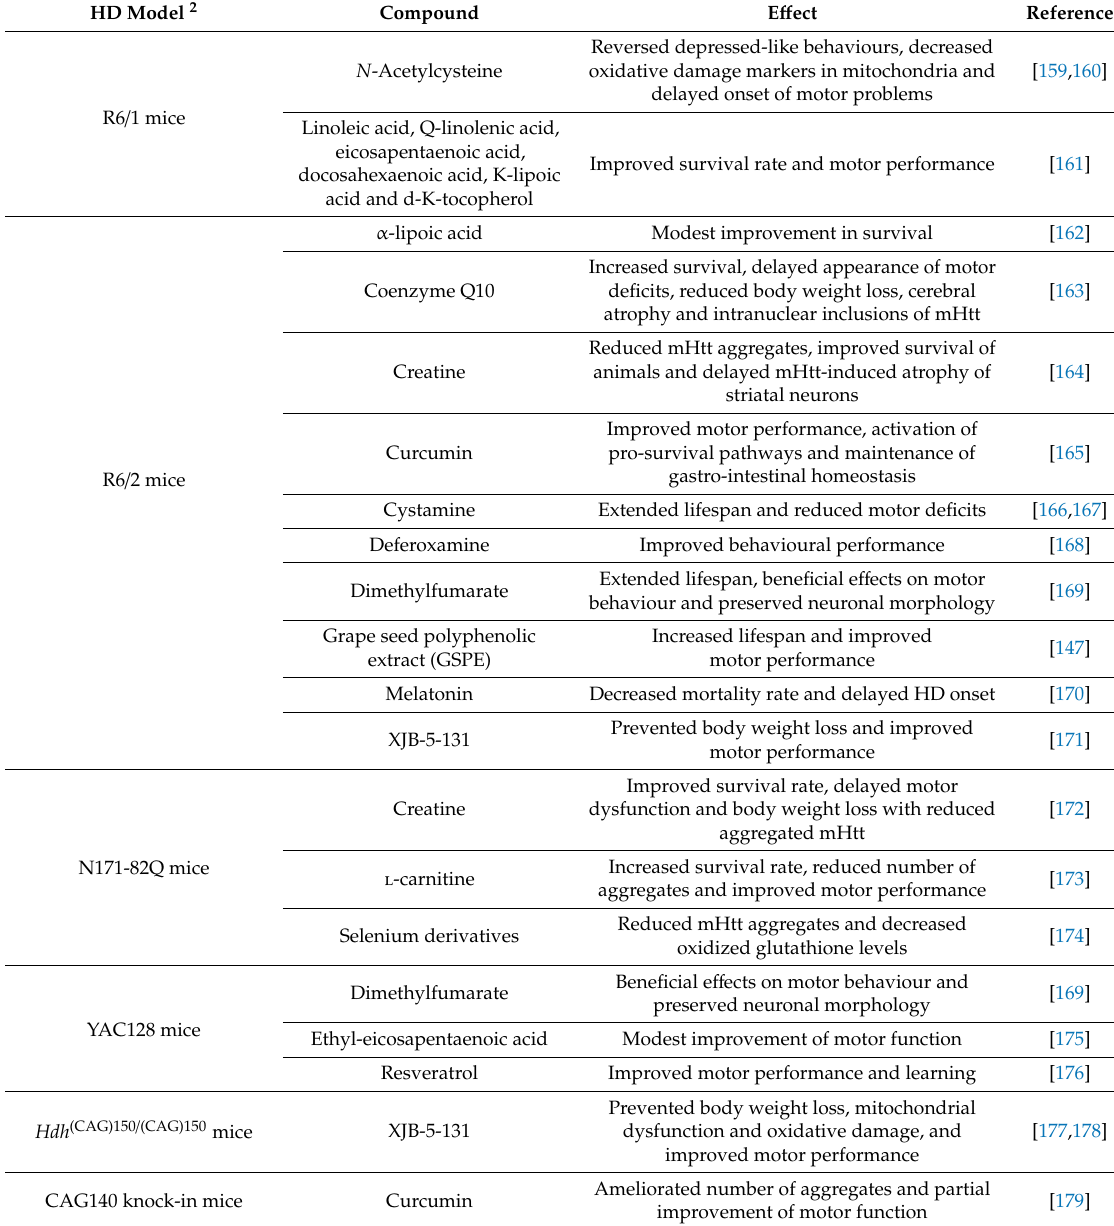
Table 3. Antioxidant therapies carried out in rodent models of HD 1